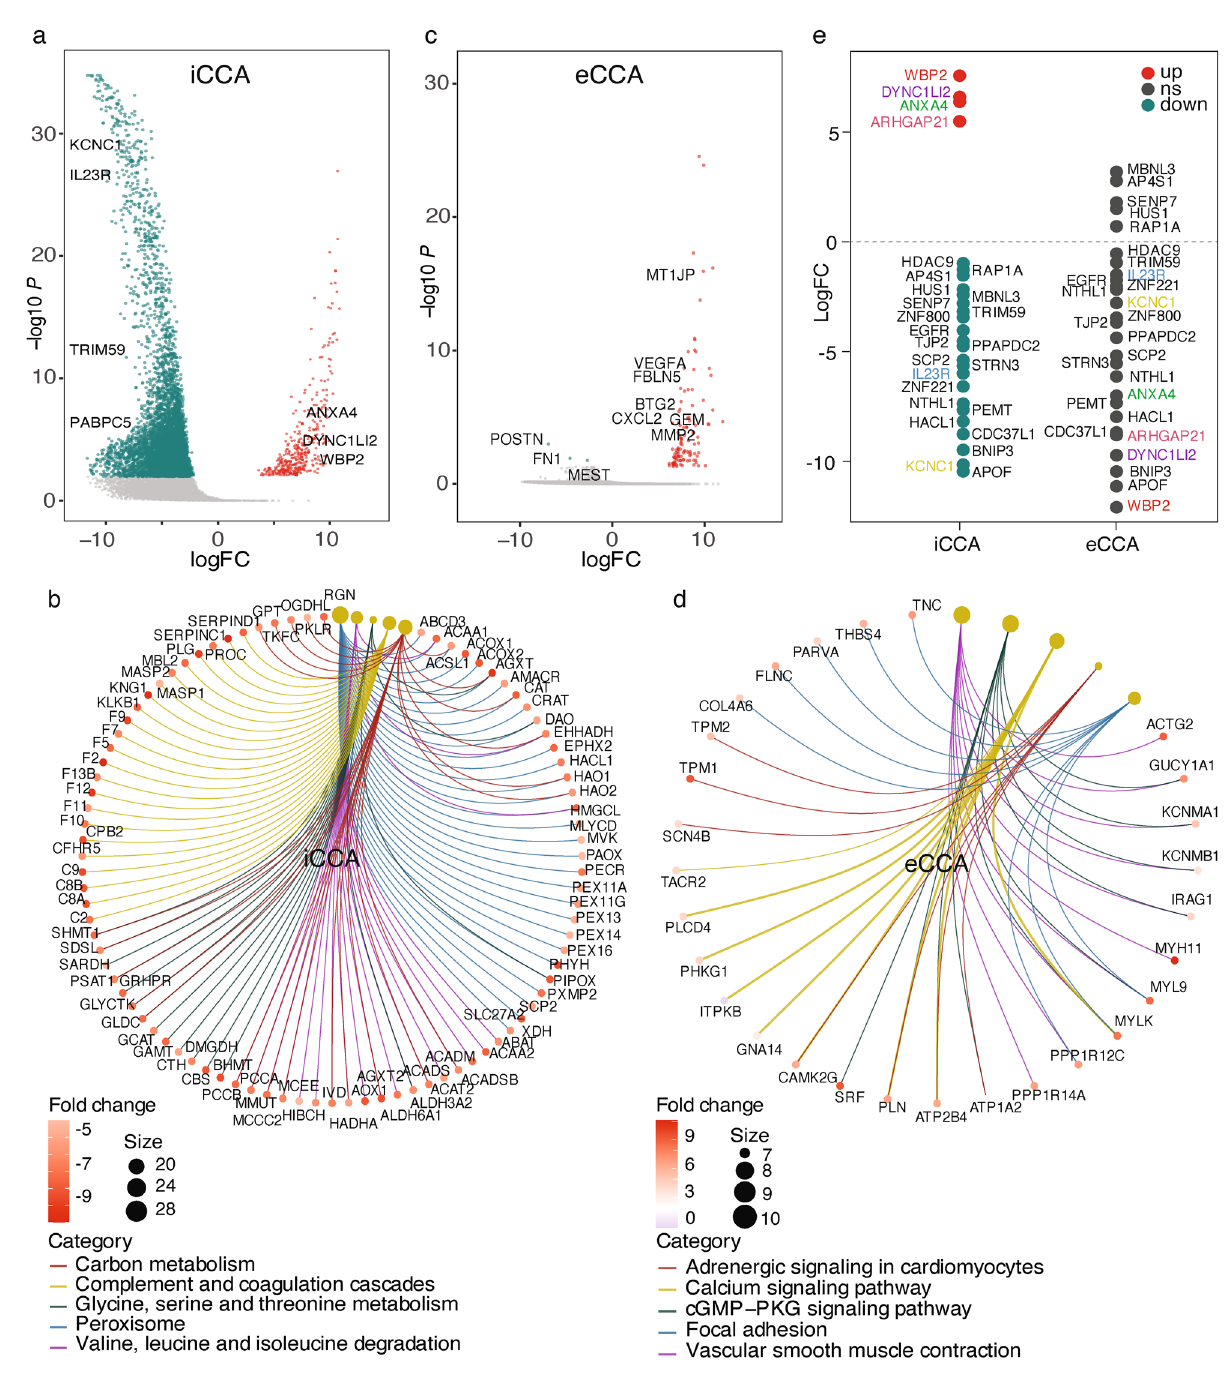
Figure 4. Volcano plots showing significant DEGs in iCCA ( a ) and in eCCA ( b ). The red spots represent significantly upregulated genes, and the green spots represent significantly downregulated genes. ( c ) Expression variations of selected DEGs in iCCA and eCCA. KEGG biological function enrichment analysis of DEGs for iCCA ( d ) and eCCA ( e )